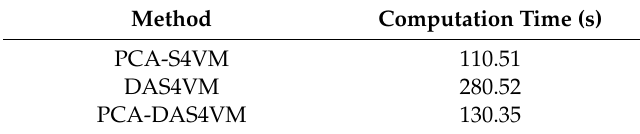
Figure 12. FDR for PCA-S4VM, DAS4VM, and PCA-DAS4VM models. Table 6. Average computation time of PCA-S4VM, DAS4VM, and PCA-DAS4VM models.